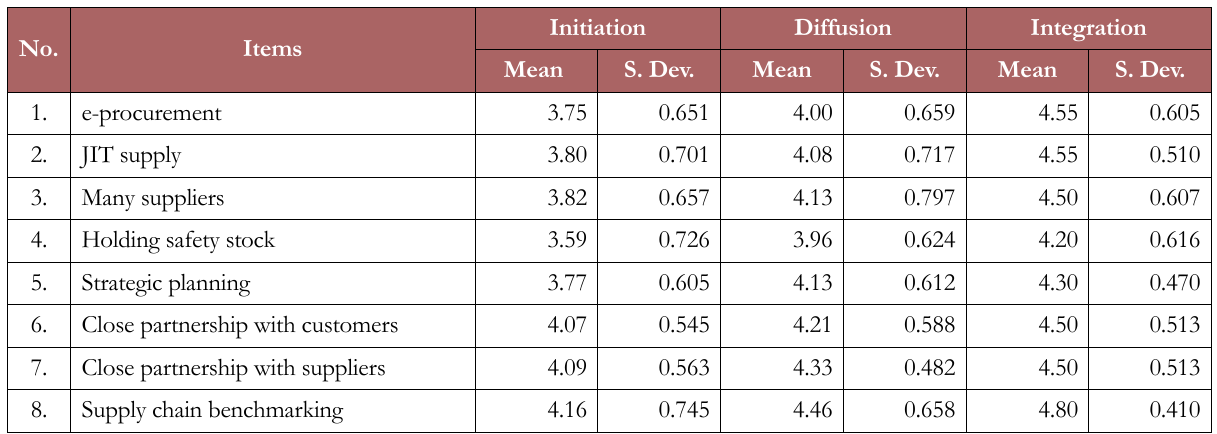
Table 5. SCM adoption level